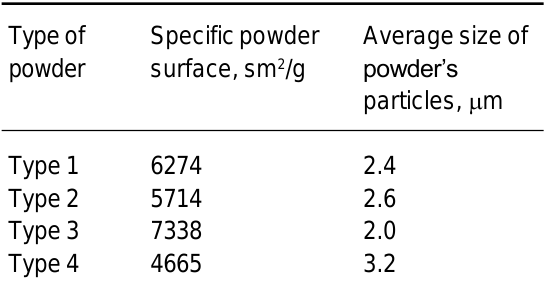
Table 2. Particle size analysis of corundum pow- ders.